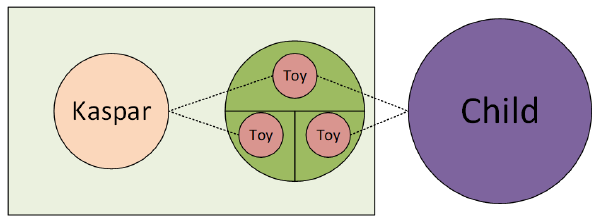
Figure 6: Equipment layout diagram for game